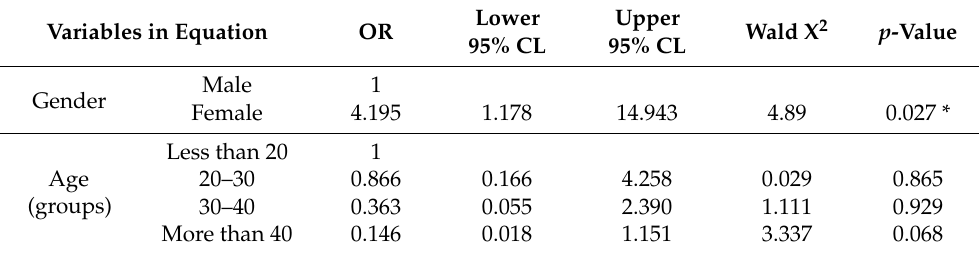
Lower Upper Wald X 2 p -Value 95% CL 95% CL